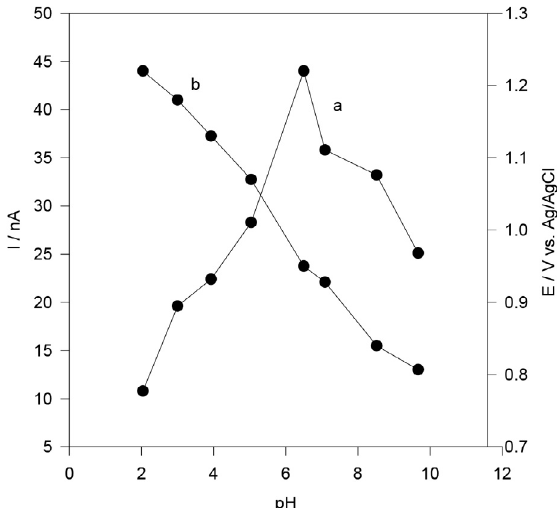
Figure 3B . Effect of pH on the differential pulse anodic peak current (a), and peak potential (b) of 3.98 × 10 –6 mol/L chlorzoxazone in 0.04 mol/L BR buffer, pulse amplitude 50 mV, and scan rate 50 mV/s.